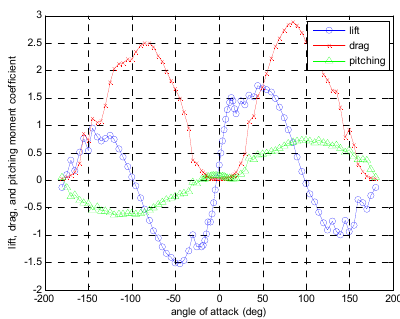
Figure 3. Lift, drag, and pitching moment coefficients at 17,750 mm based on the blade root.